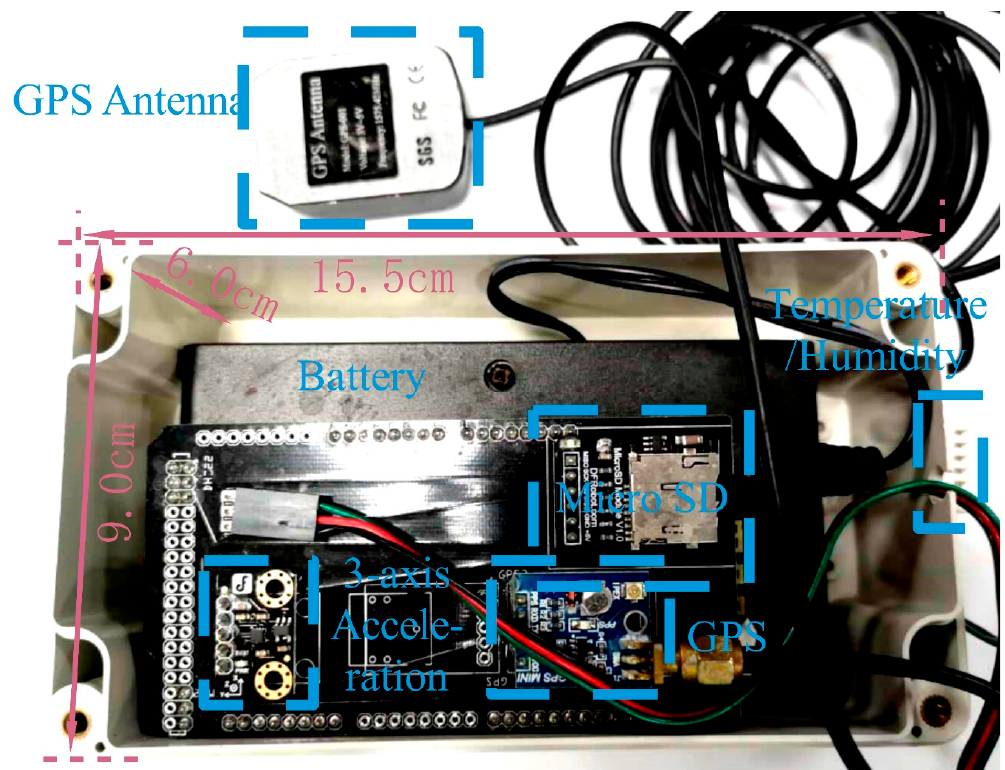
Figure 7. Device of the designed master unit.